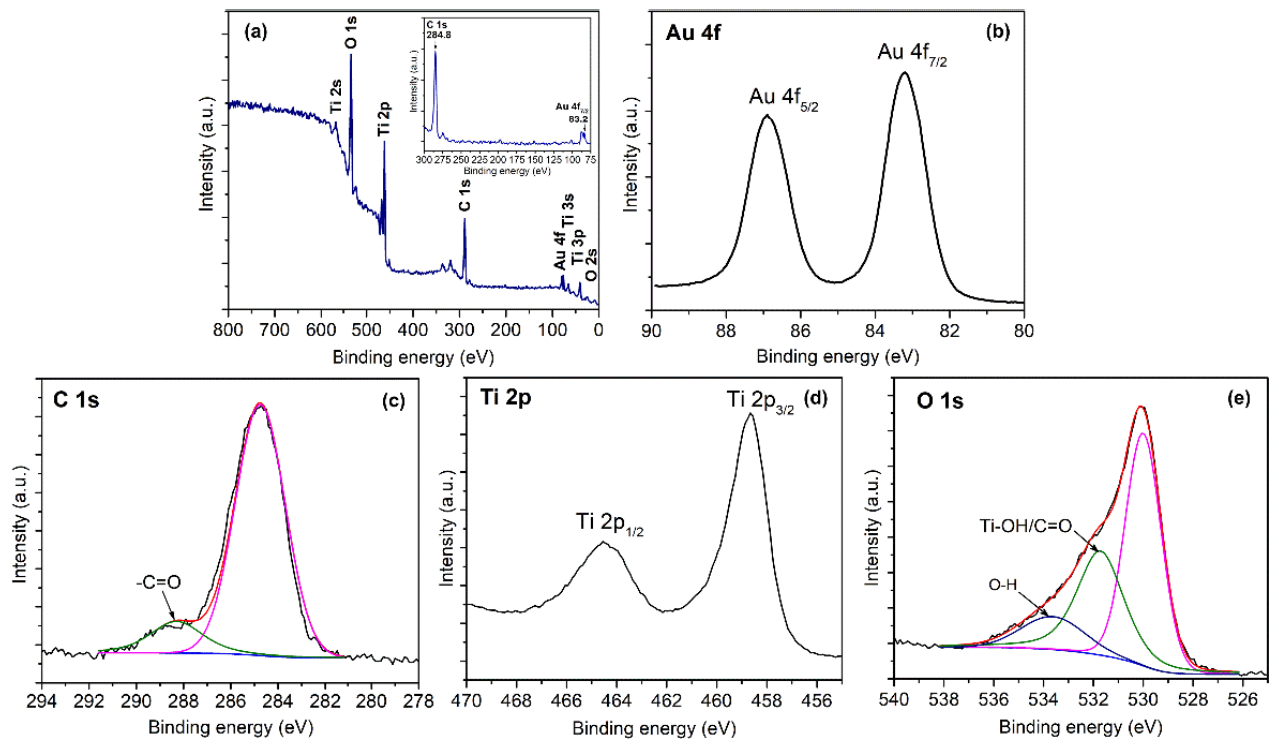
Figure 6. ( a ) Wide-scan XPS spectrum of Au NPs-NRs-TNWs/TNAs (S 4 ); Inset shows Au 4f and C1s calibrated at 284.8 eV. High-resolution spectrum for ( b ) Au 4f; ( c ) C 1s; ( d ) Ti 2p; ( e ) O 1s. To evaluate the PEC activity of TNWs/TNAs and Au-TNWs/TNAs, linear sweeping voltammetry (LSV) curves were performed using the sample as photoanode, Pt as a counter electrode, and Ag/AgCl as a reference electrode and under the UV-Vis irradiation. As shown in Figure 7a, without illumination, all the TNWs/TNAs and Au-TNWs/TNAs photoanodes exhibited negligible photocurrent density ( J ) in the whole potential range [44]. The J increased remarkably for all the photoanodes with illumination, indicating typical properties of the semiconductor. Moreover, the J of Au-decorated TNWs/TNAs was remarkably higher than that of TNWs/TNAs photoanode. At 0.15 V, the J values of S 1 , S 2 , S 3 , and S 4 were 0.24, 0.32, 0.31, and 0.40 mA/cm 2 , respectively (Figure 7a). This means that Au NPs-NRs-TNWs/TNAs (S 4 ) possessed the highest PEC activity among all the investigated photoanode nanomaterials.